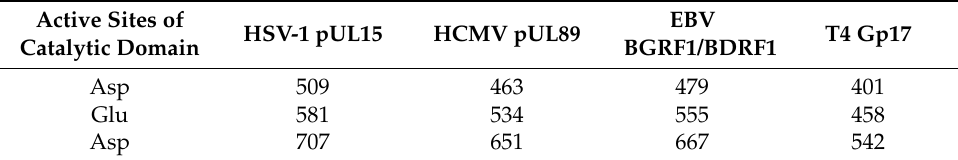
Table 2. Catalytic site of nuclease activity in pUL15 and